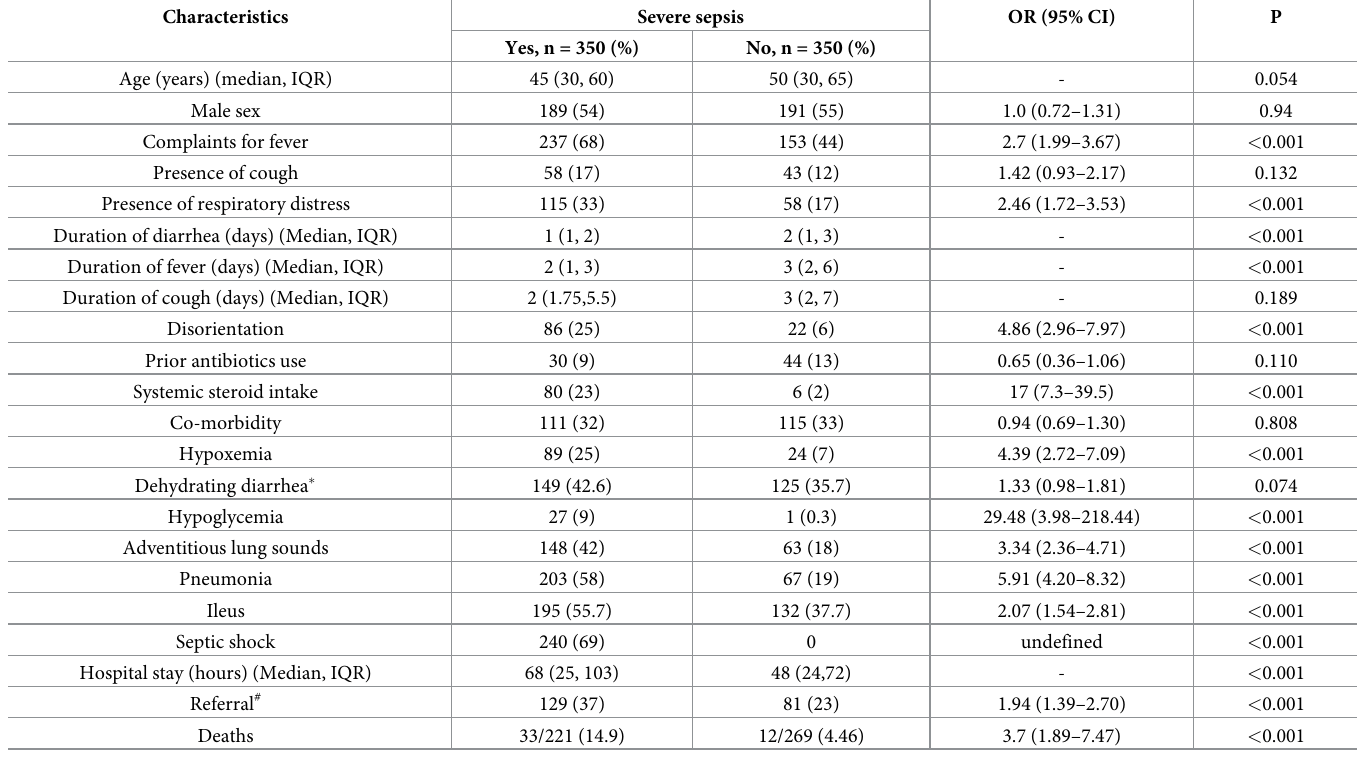
Table 1. Clinical characteristics of diarrheal patients with and without severe sepsis.